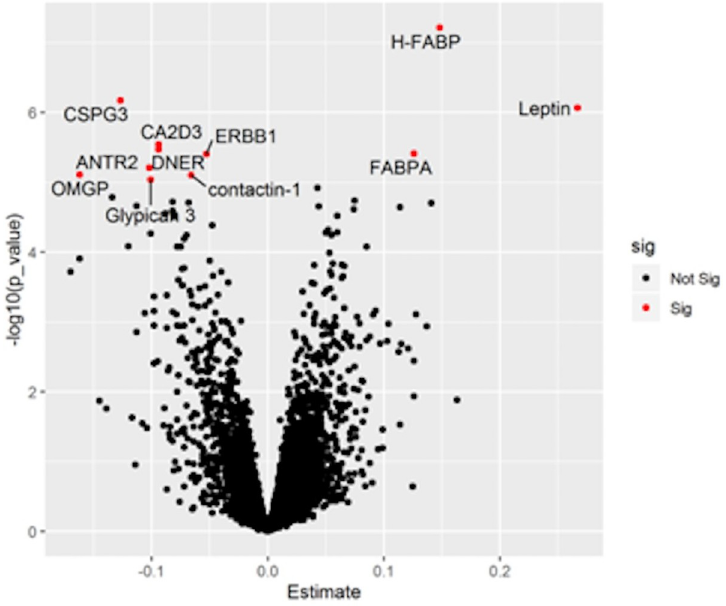
Fig 4. Association of proteins with frailty trajectories. Volcano plot with top proteins associated with frailty trajectories after Bonferroni correction annotated and in red (see S3 Table in S1 File). X-axis denotes Beta estimate coefficients from linear model. Y-axis shows significance levels presented as -log 10 ( p